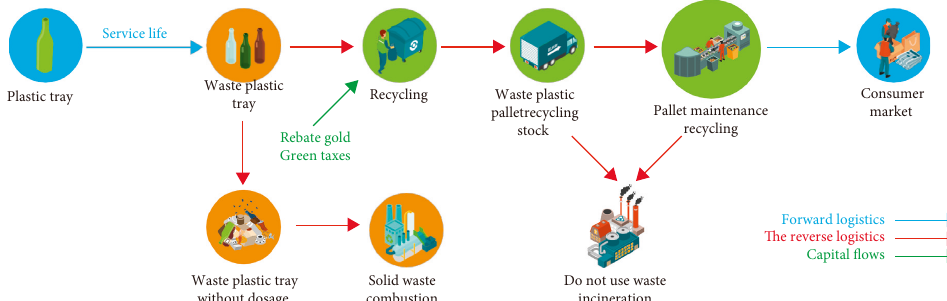
Figure 1: Structural block diagram of the recycling model of the waste plastic